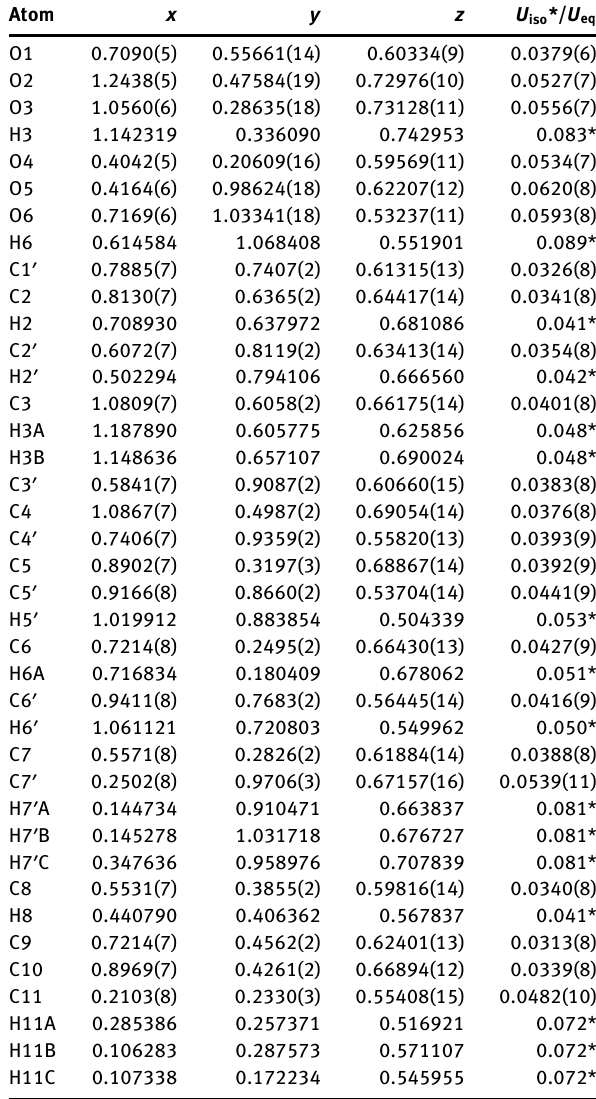
Table 2: Fractional atomic coordinates and isotropic or equivalent isotropic displacement parameters (Å 2